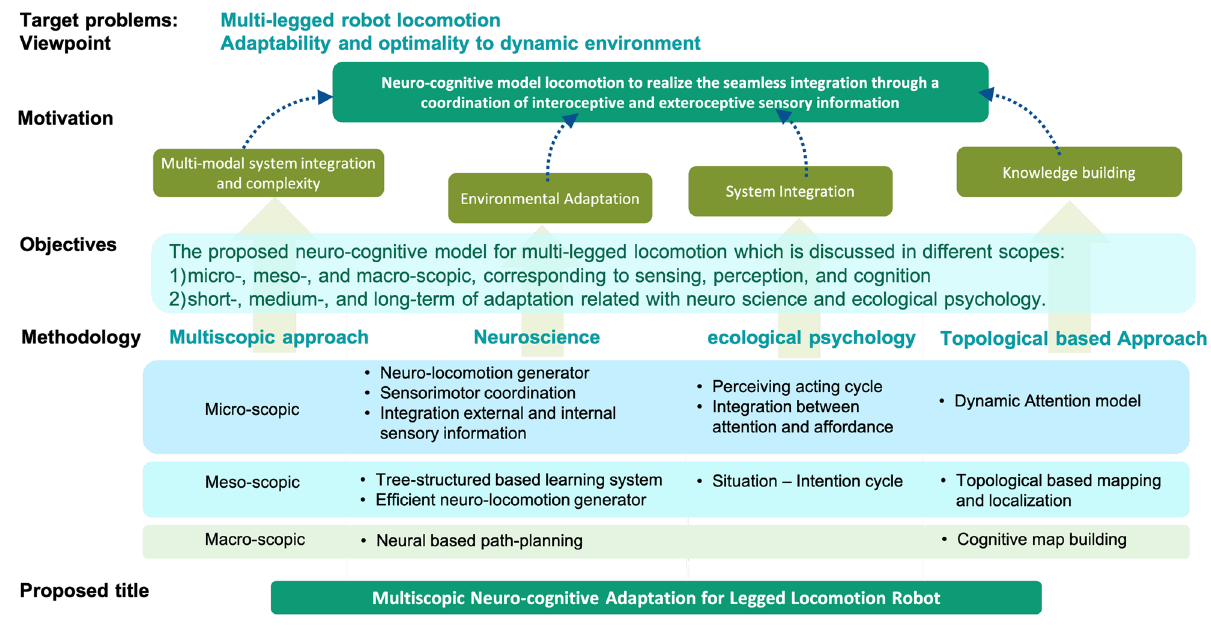
Figure 1. Methodology of the proposed